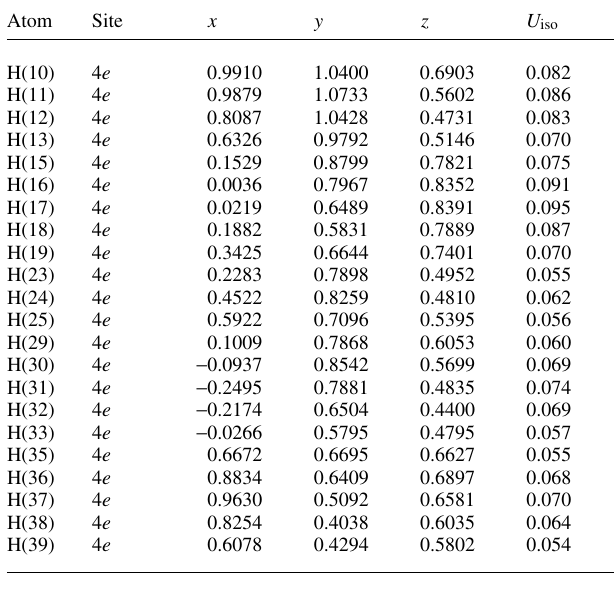
Table 1. Data collection and